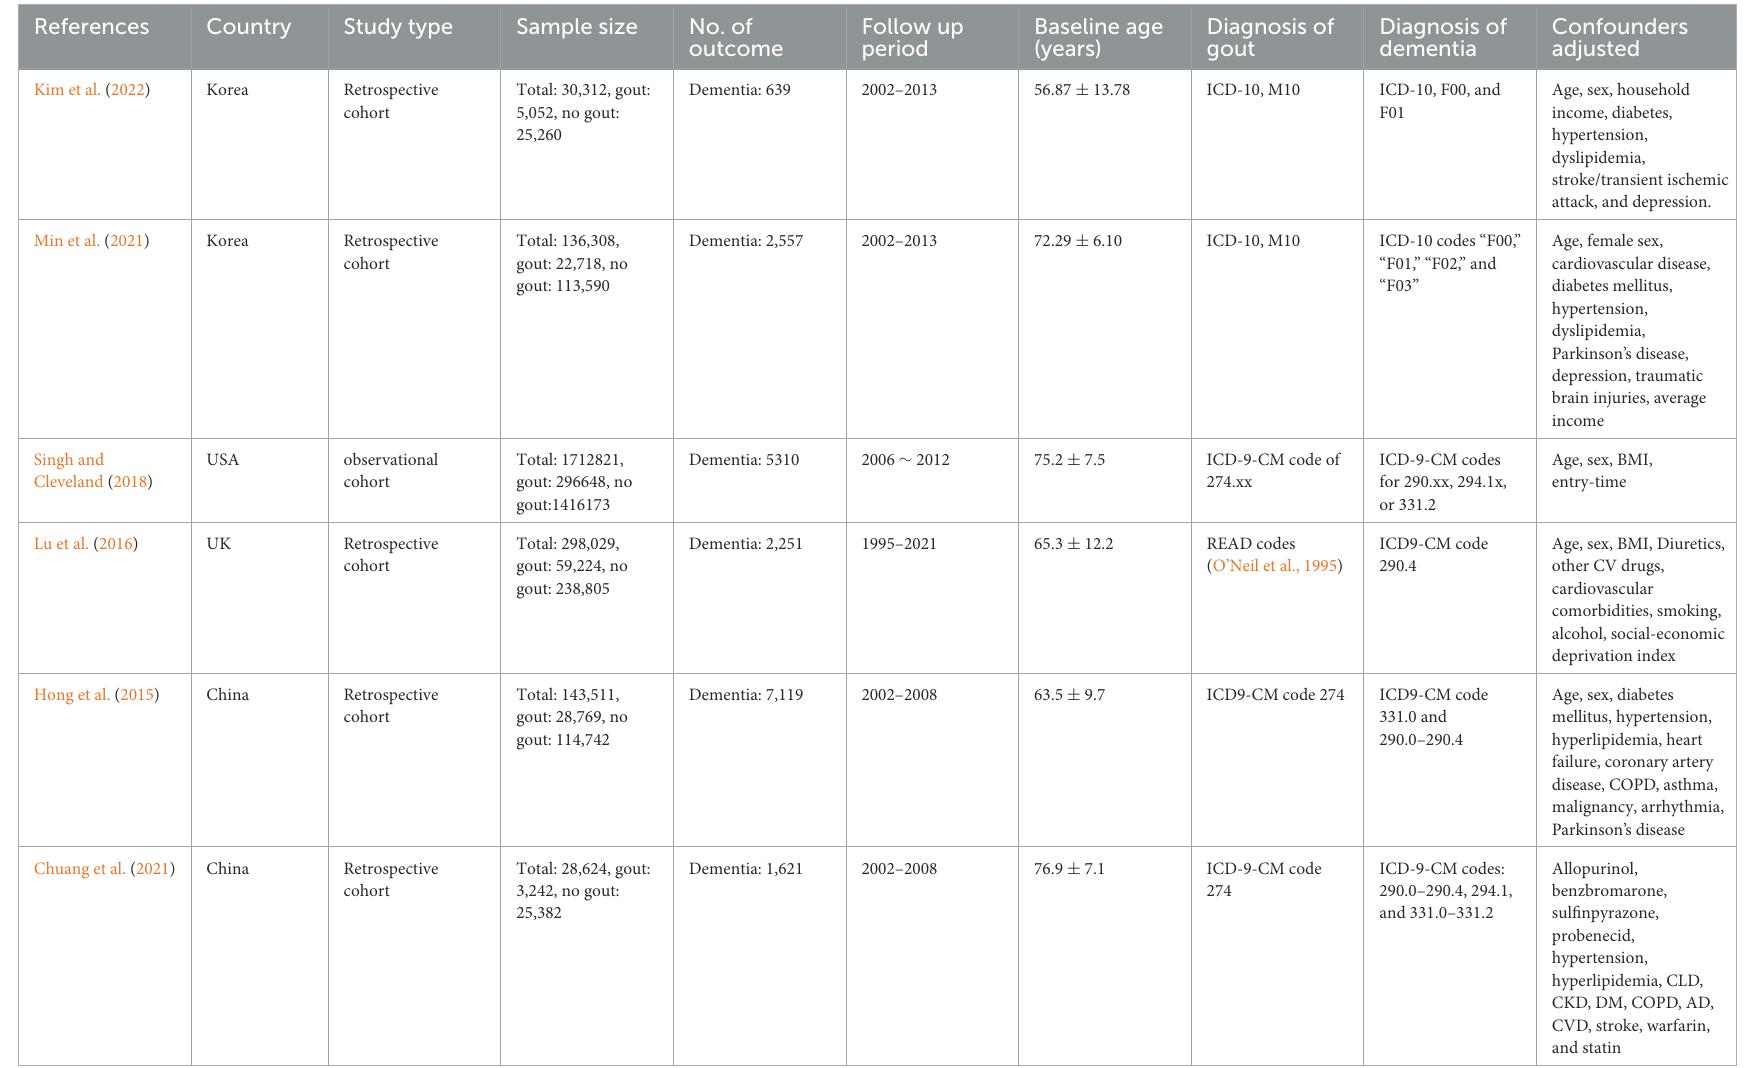
TABLE 1 Characteristics of studies included in the